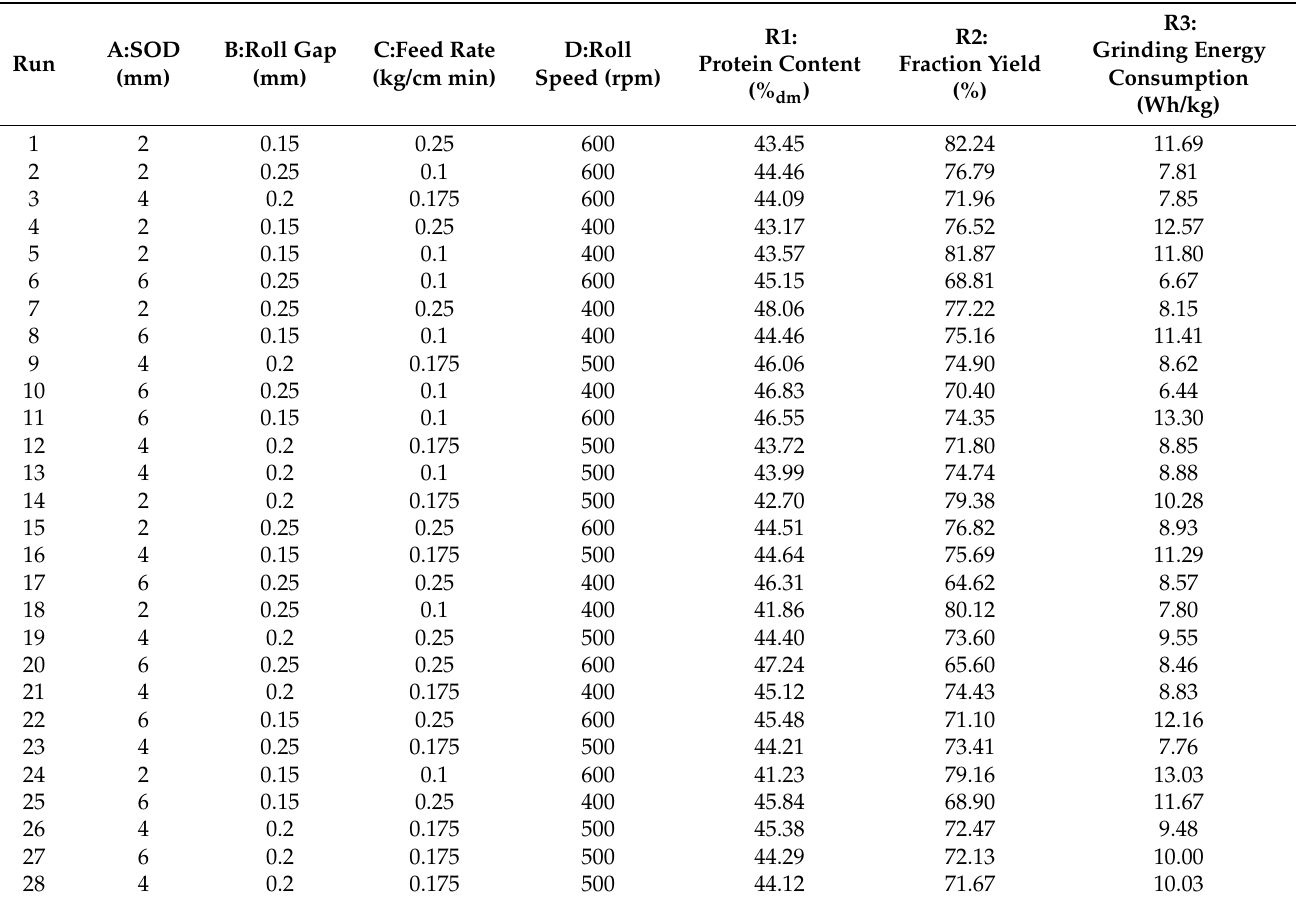
Table 3. The Face-centred central-composite design and experimentally determined values of targeted